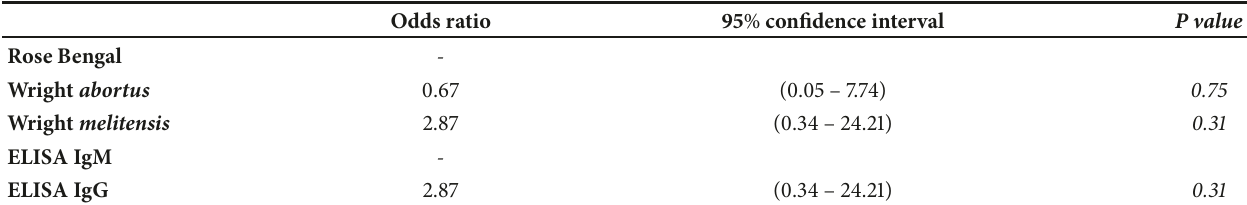
Table 2: Odds ratio for positive test in high- versus low-risk